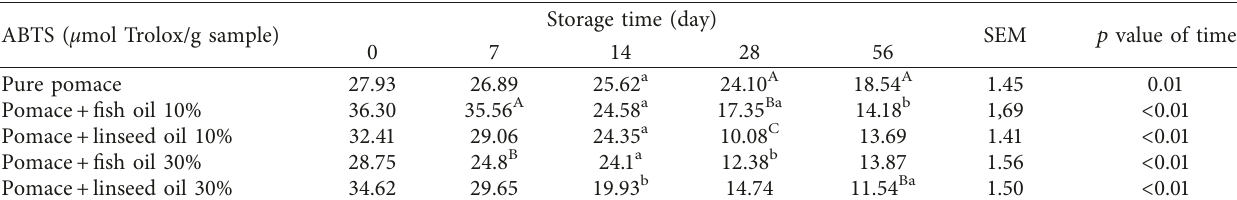
Table 4: The antioxidant activity (ABTS • + ) of apple pomace together with the tested oils ( µ mol Trolox/g). ABTS ( µ mol Trolox/g